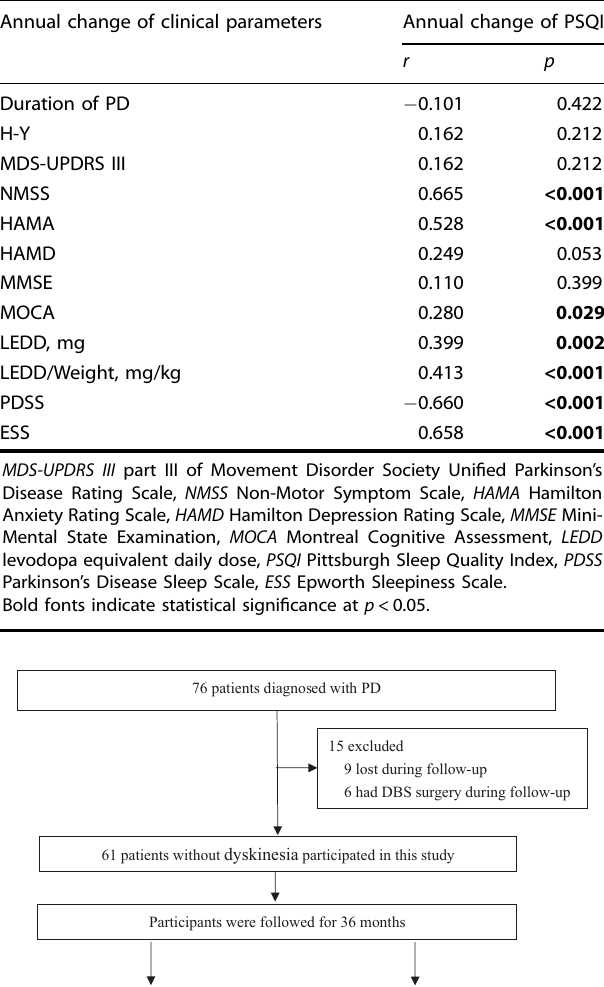
Table 3. Correlation between the annual change of PSQI and annual changes of other clinical parameters.